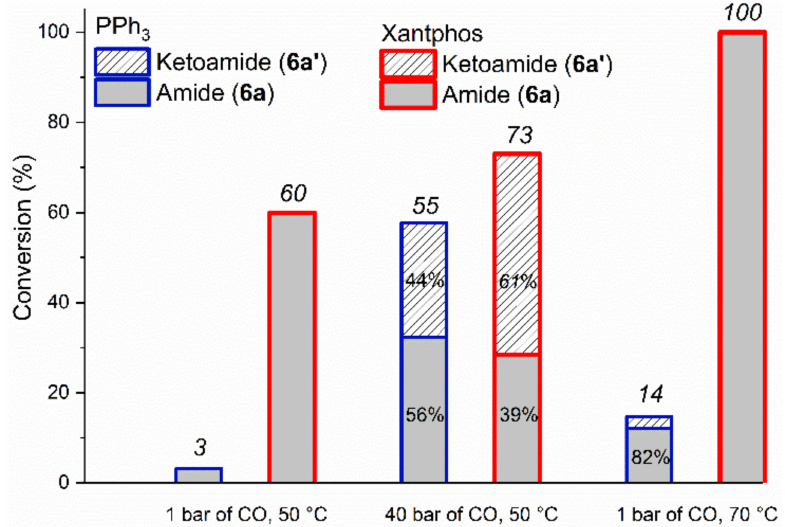
Figure 1. Conversion of 6 in the presence of a as a function of reaction conditions used during their aminocarbonylation in DMF after 24